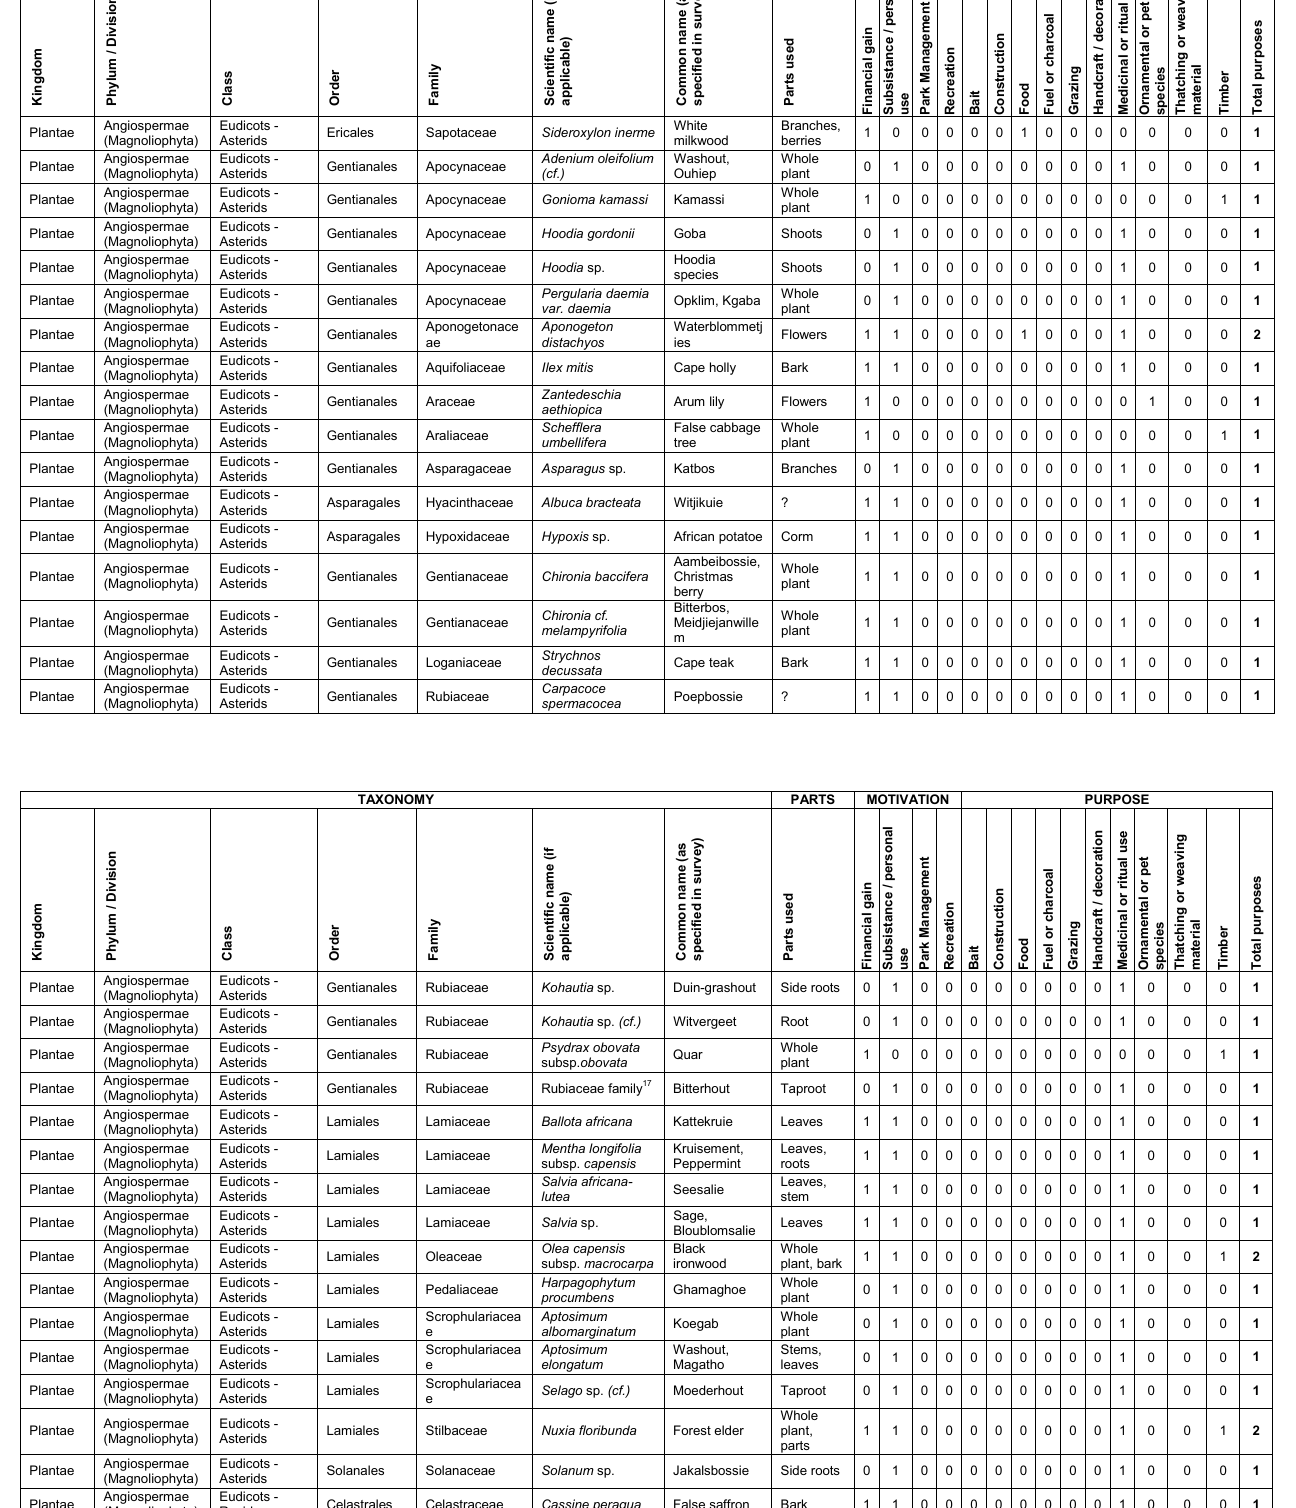
Whole plant, parts